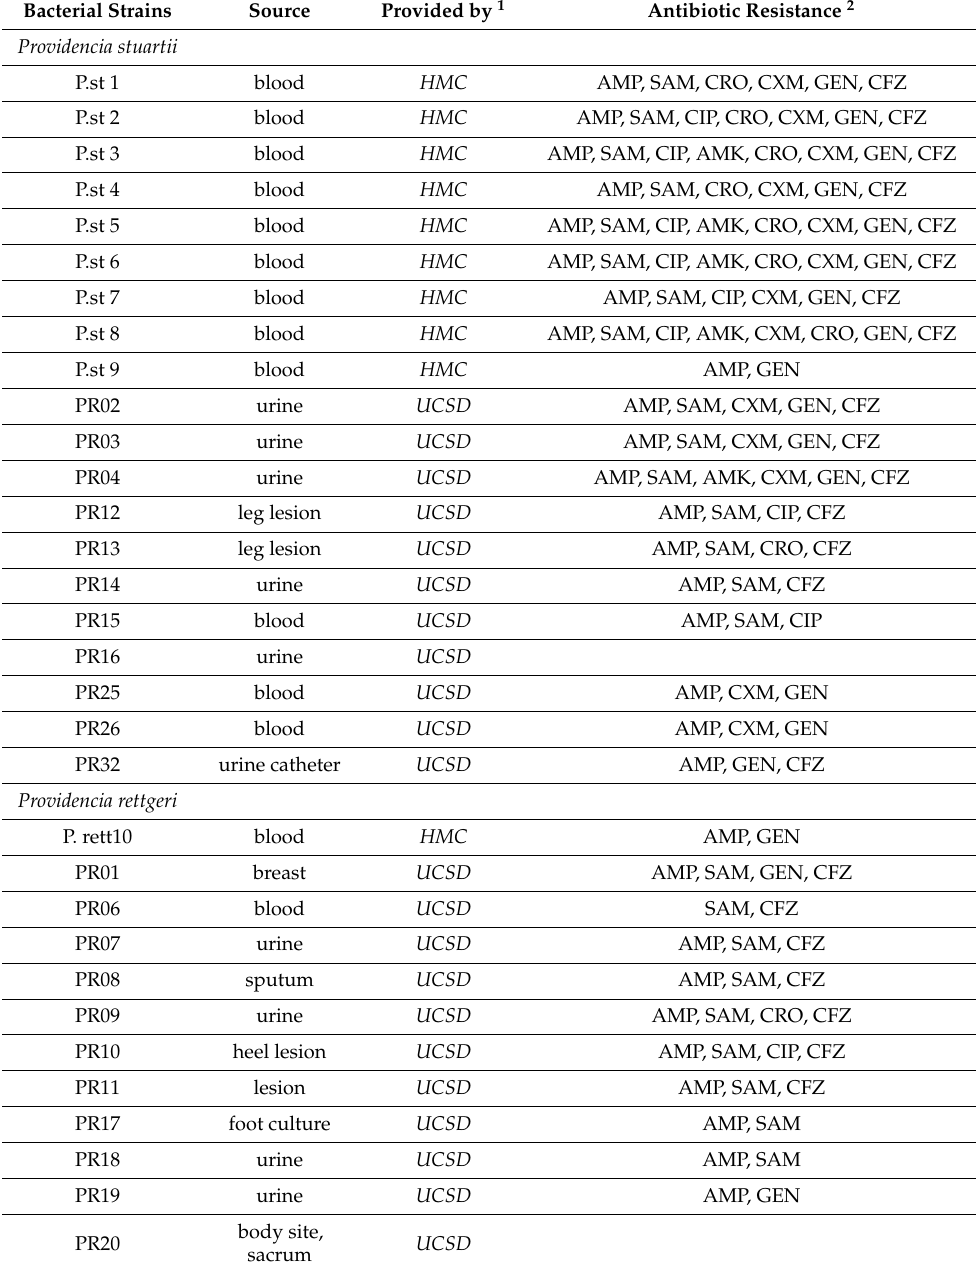
Table 2. Bacterial strains, their body site source, the provider of the isolates and antibiotic resistance. Bacterial Strains Source Provided by 1 Antibiotic Resistance 2 Providencia